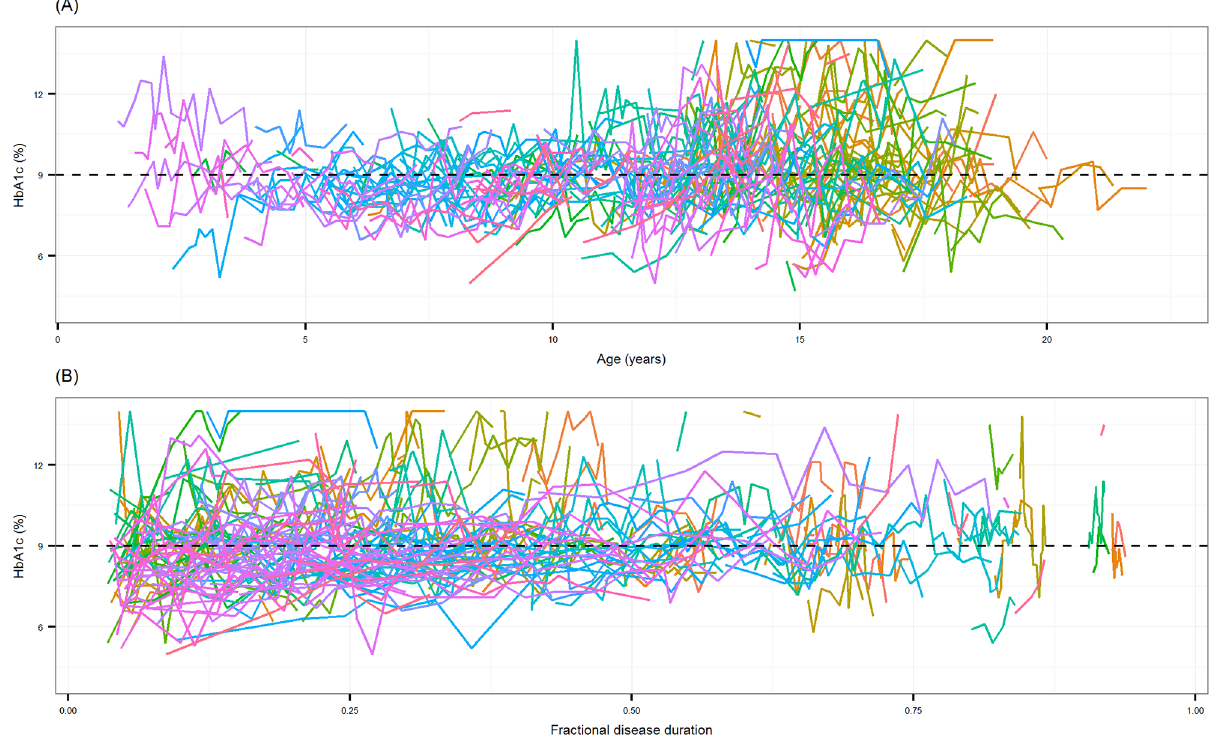
Fig 1. A: HbA1c measurements (%) versus age (years). B: HbA1c measurements (%) versus fractional disease duration. Individual lines connect all observations for a patient. Dashedlines show the HbA1c cut-off value (9%) for satisfactory glycaemiccontrol.